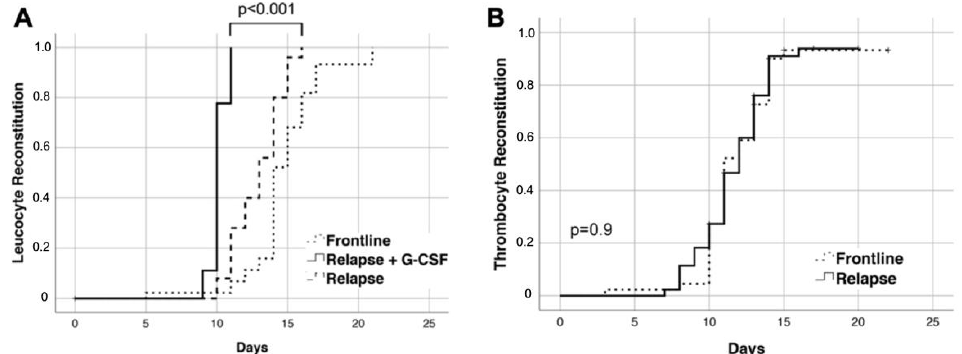
Figure 5. Time to reconstitution of peripheral blood counts. ( A ) Time to reconstitution of peripheral blood leukocytes (>1/nl) according to frontline and salvage HDCT/ASCT. For salvage HDCT/ASCT, reconstitution with and without G-CSF use was plotted separately. ( B ) Time to reconstitution of peripheral blood platelets (>20/nl) according to salvage and frontline HDCT/ASCT. Time to reconstitution was calculated from ASCT.